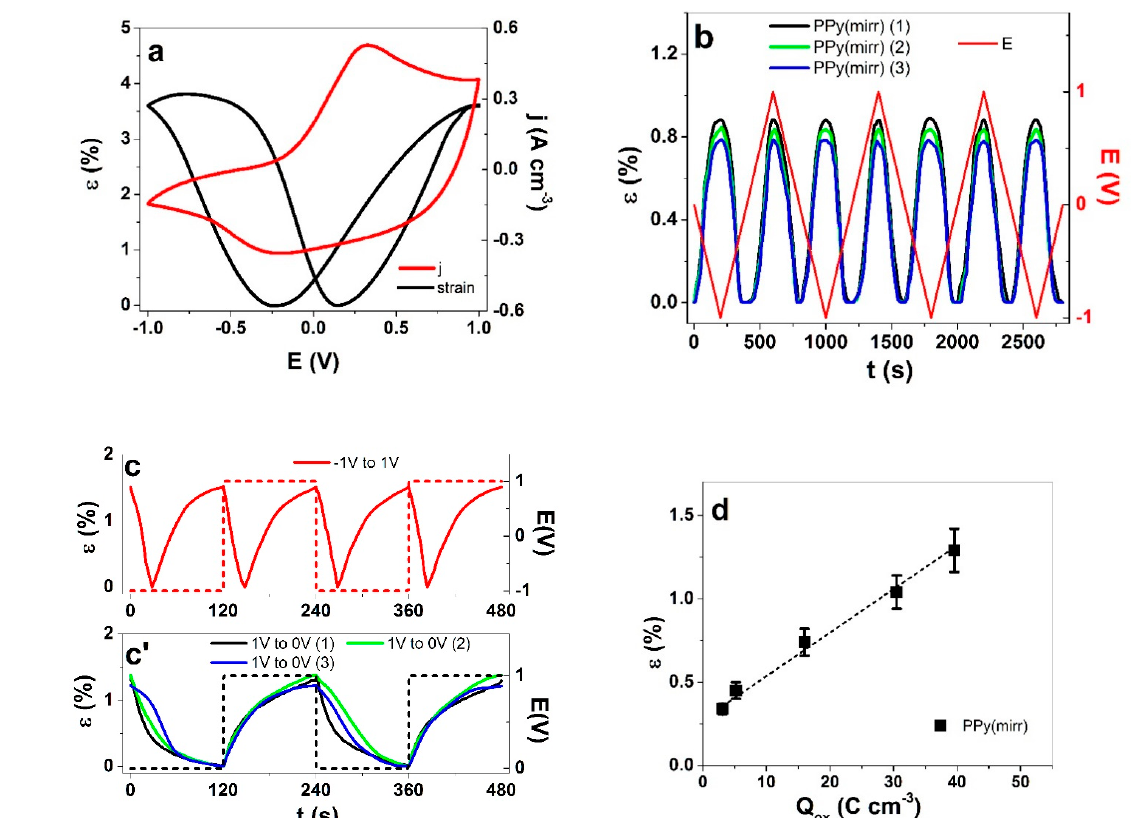
Figure 9. Linear actuation response to cyclic voltammetry (5 mV s − 1 ) in 0.1 M TBACF 3 SO 3 PC as strain (black) and current density (red) of ( a ) PPy(pot, 0.75 V) and ( b ) PPy(mirr) (repeatability shown by three samples: black, green and blue) against time t with applied potential E (dashed, red). The PPy(mirr) strain response to square wave potential steps (cycles 3rd–4th) at 4.17 mHz against time t ( c ) potential range from − 1 V to 1 V (red) and ( c’ ) potential 0 V to 1 V (red line) with strain response of three samples (black, green and blue). Strain ε ( ■ ) against charge density Q ox in potential range 0 V to 1 V is shown in ( d ). The dashed line in ( d ) represents the linear fit and is shown for orientation only.